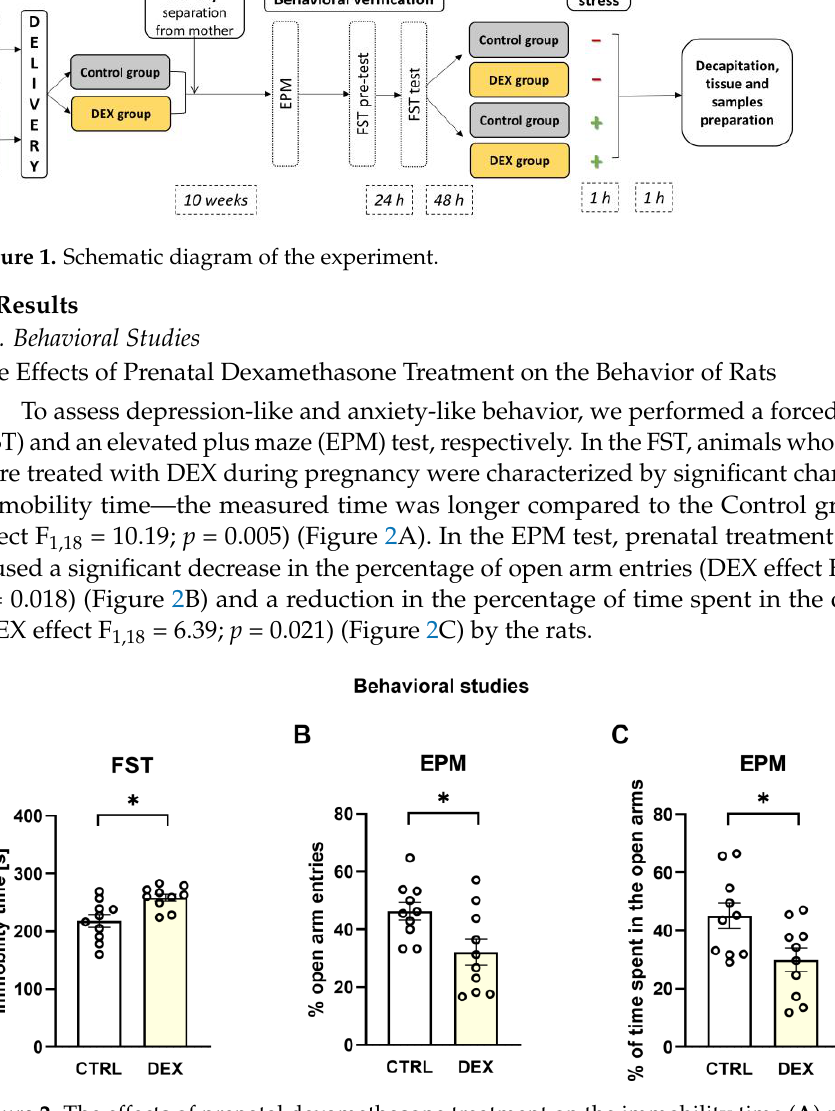
Figure 2. The effects of prenatal dexamethasone treatment on the immobility time ( A ) measured in the FST, % of open arm entries ( B ) and % of time spent in the open arms ( C ) of the EPM; * p < 0.05, n = 10. The results are expressed as the mean ± SEM. Statistics: one-way ANOVA.